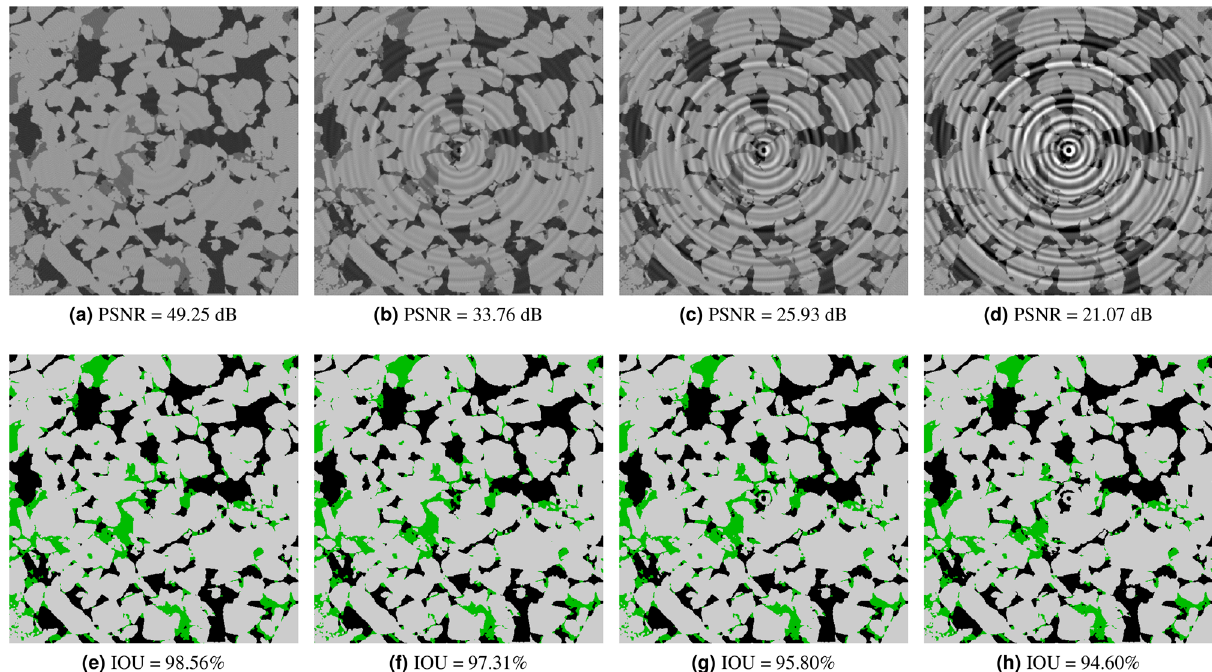
Figure 8. Segmentation results for the reservoir sandstone on synthetic images generated with ring